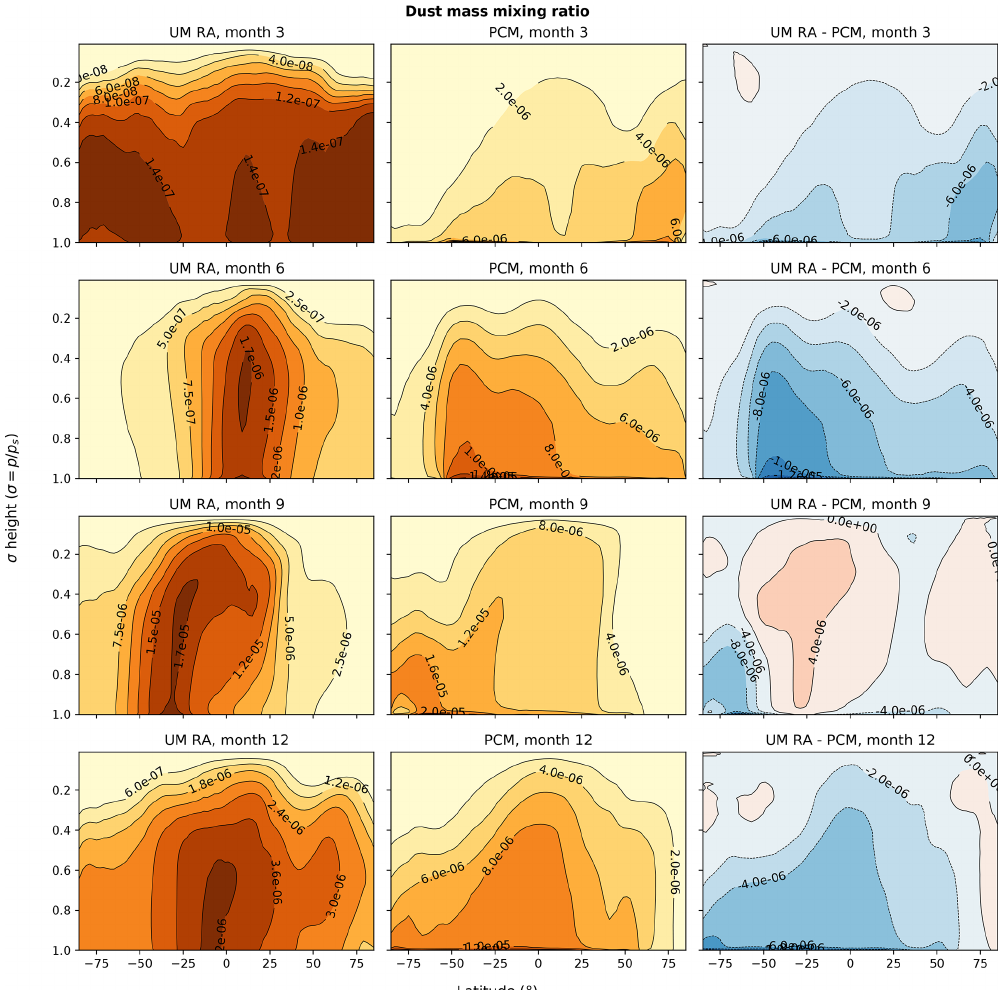
Figure A9. Zonal mean dust mass mixing ratio (kgkg − 1 ) across four seasons within the Martian year; each month is the average taken of all sols within that month (months according to Table A1). The RA dust scenario is shown on the left, the PCM output in the centre and the differences between models on the right. Contour lines denote the mass mixing ratio and units are in kgkg − 1 . Note that, due to the wide range of values present between months, the colour scale ranges differ between months and scenarios for this